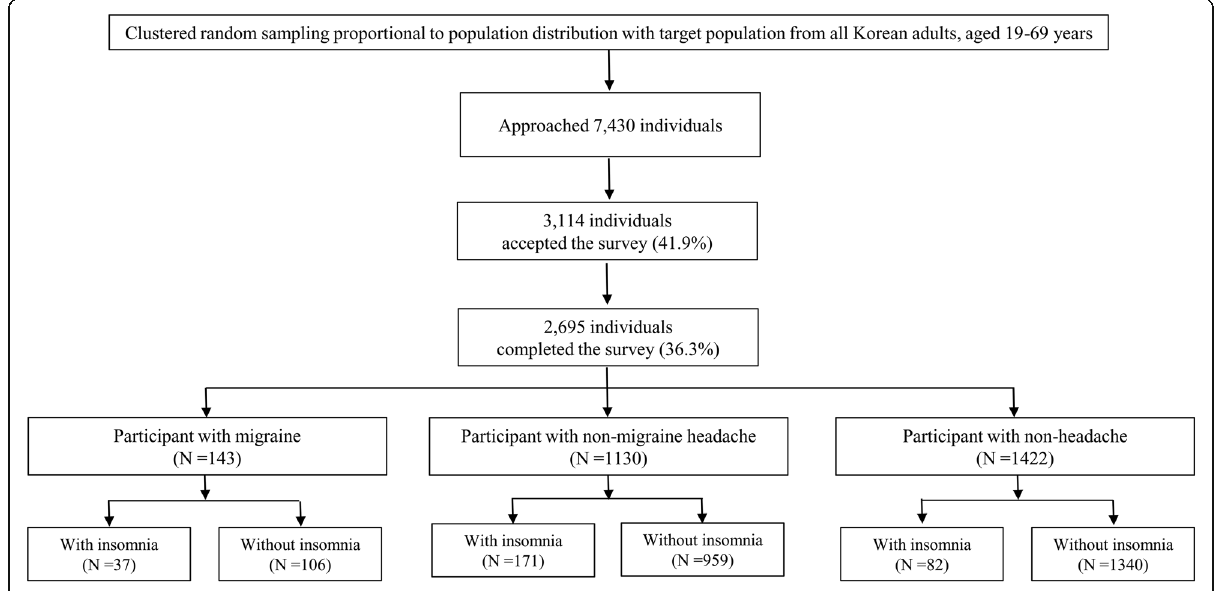
Fig. 1 Flowchart depicting the participation of subjects in the